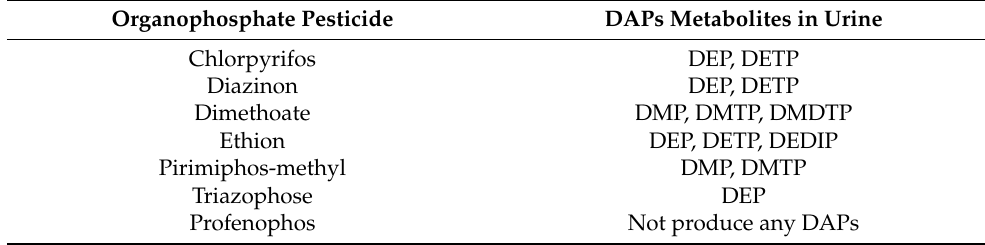
Table 5. Organophosphate pesticides and DAP degradation products in urine